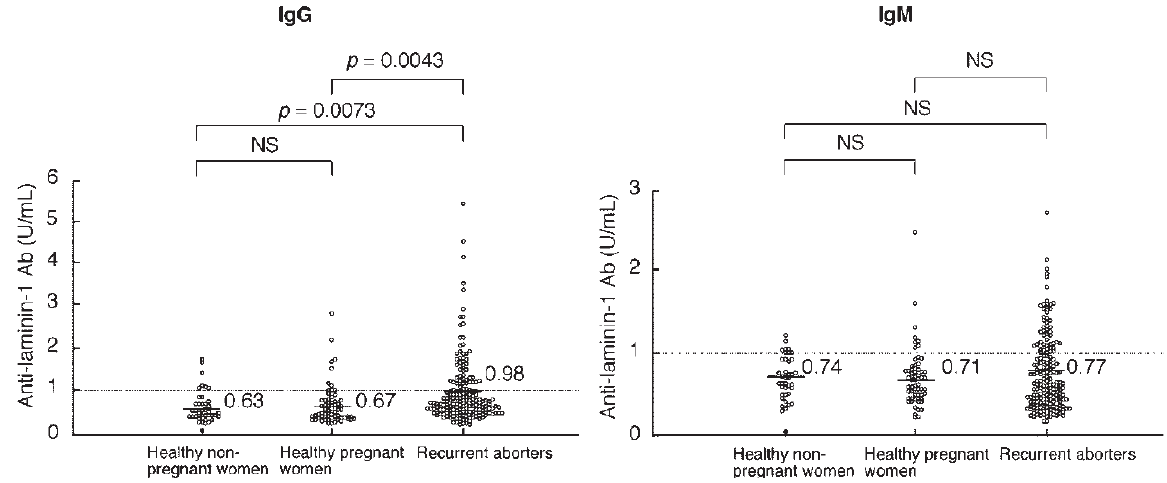
FIGURE 2 Levels of IgG or IgM anti-laminin-1 antibodies in recurrent spontaneous aborters. Anti-laminin-1 antibodies were detected in ELISA using a laminin-1-coated plate. The dotted line shows 1U/ml (1U/ml ¼ OD, the mean þ 3 SD of healthy non-pregnant women), as a cut off value of the antibodies. Solid lines show the mean value. (Inagaki et al. , 2001).